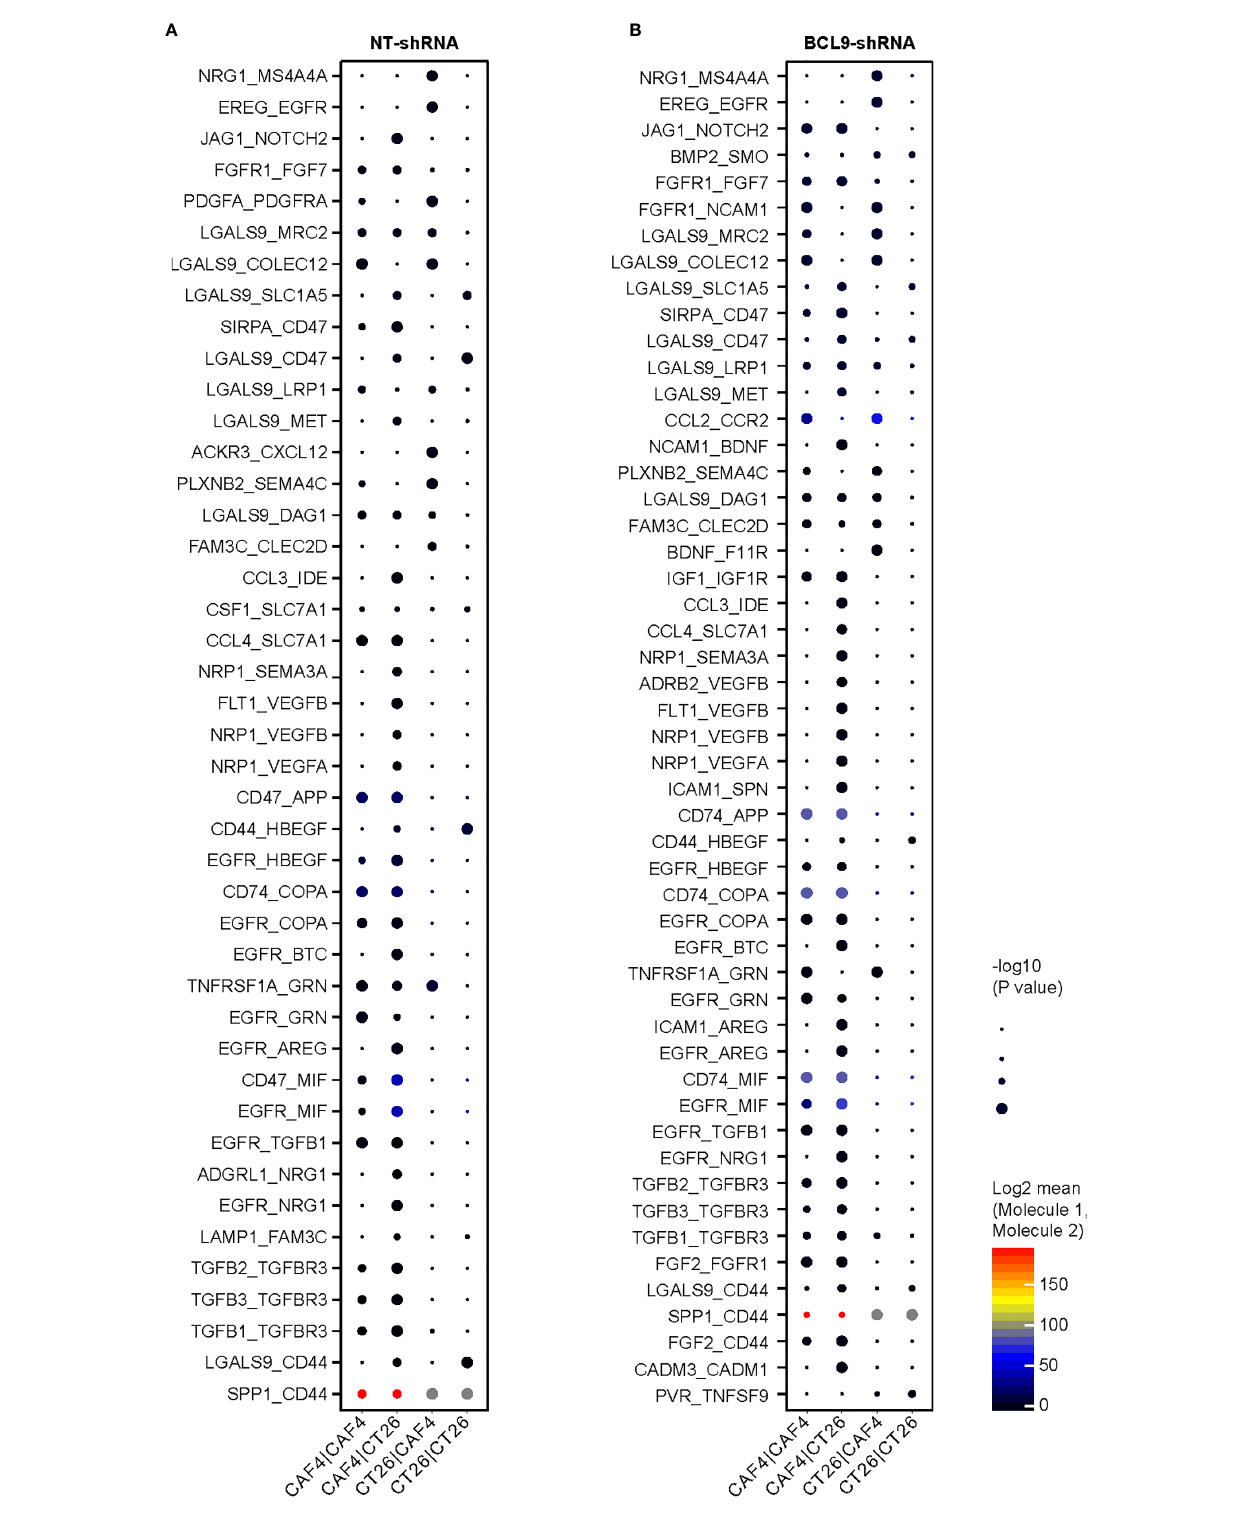
FIGURE 5 | Tumor CAF interaction in mouse CT26 tumor. Cell interaction in normal tumor (NT) and knockdown (KD) groups. (A) The binding between receptor and ligand is obvious in CAF/CT26 in NT subgroups. (B) The binding between receptor and ligand is obvious in CAF/CT26 in KD